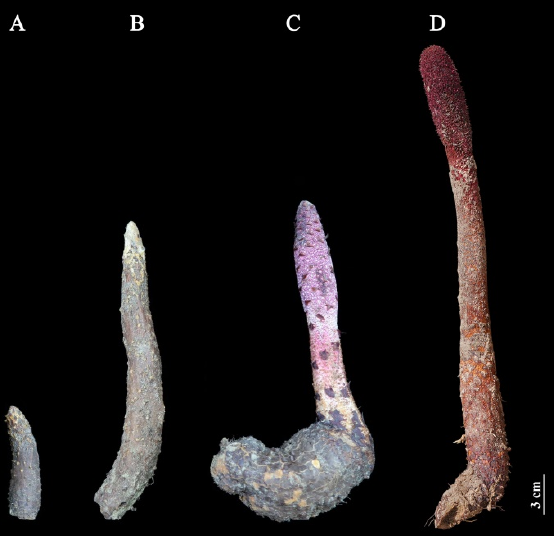
Figure 12. Morphological stem of C. songaricum at GS ( A ), VGS ( B ), EFS ( C ), and FS ( D ).